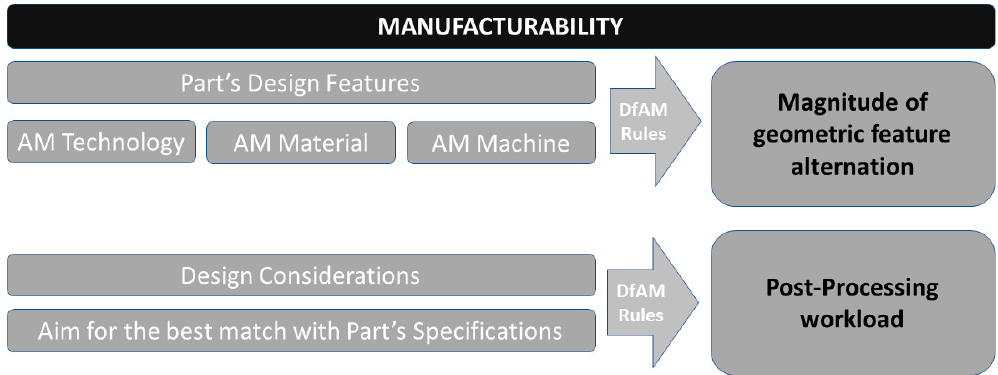
Figure 2. Part manufacturability for AM.